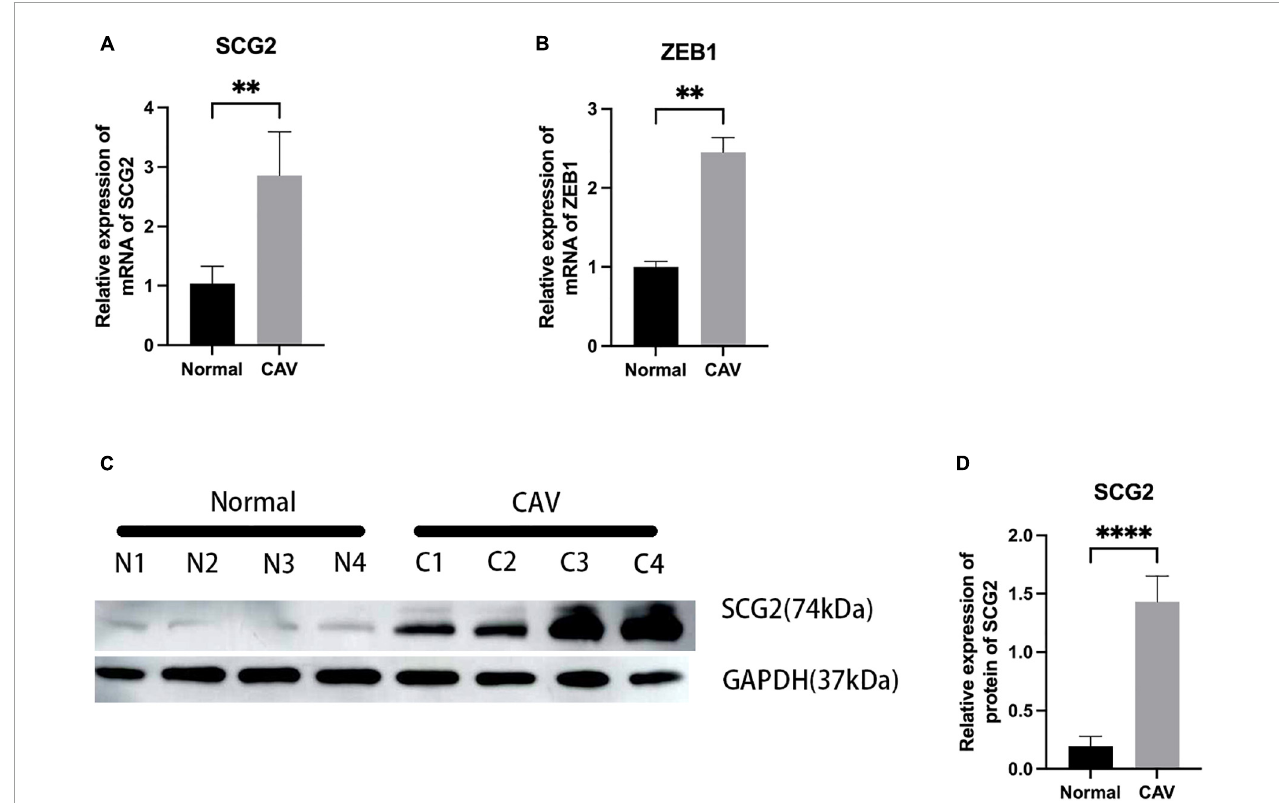
FIGURE8 Validation of SCG2 and ZEB1 in the calcified aortic valve. (A,B) The mRNA expression levels of SCG2 and ZEB1 in valves from normal patients ( n = 5 biologically independent samples) and calcification patients ( n = 5 biologically independent samples) were obtained by RT-PCR and normalized with GAPDH. (C,D) The protein expression level of SCG2. The bar graphs represent the expression levels of SCG2 protein in normal and calcified tissues. Valves from normal patients and CAVD patients were validated by Western Blotting. N1-N4 represent different samples of normal individuals, C1-C4 represent four individuals with CAV. ImageJ and GraphPad Prism softwares were used to analyze the expression level of SCG2 protein in normal and calcified aortic valves. Mann–Whitney U, ∗ p < 0.05, ∗∗ p < 0.01, ∗∗∗∗ p < 0.001, normal, control; CAV, calcified aortic